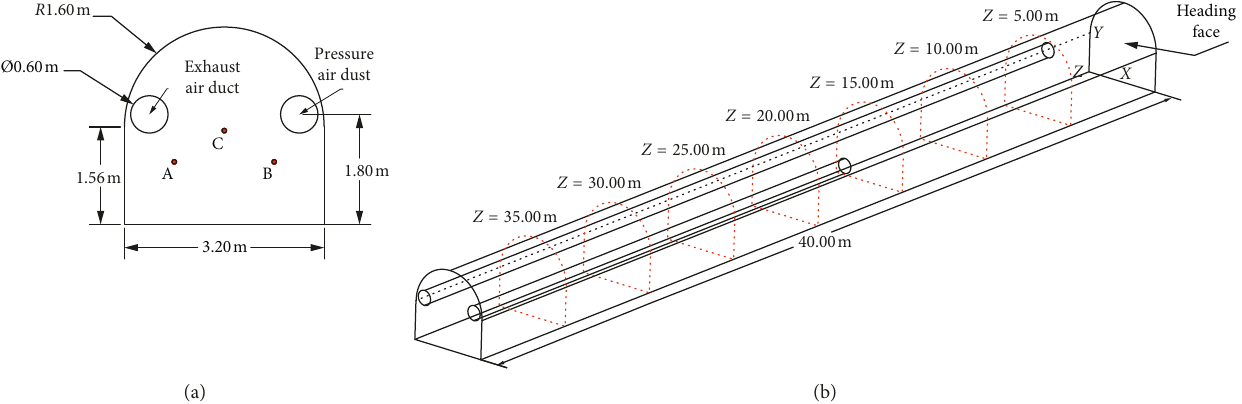
Figure 2: The diagram of the excavation working face. (a) The cross section of the physical model and (b) three-dimensional computational